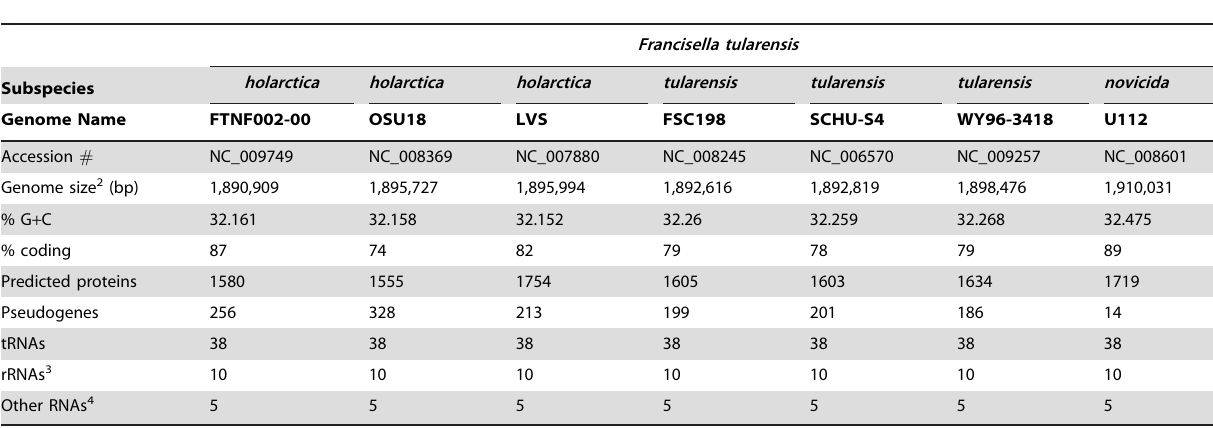
Table 1. Overview of general genome features of fully sequenced F. tularensis strains.